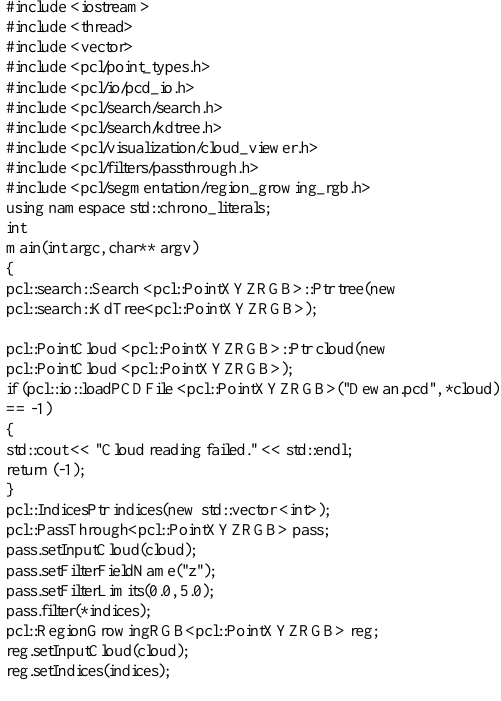
Figure 7: Source codes used